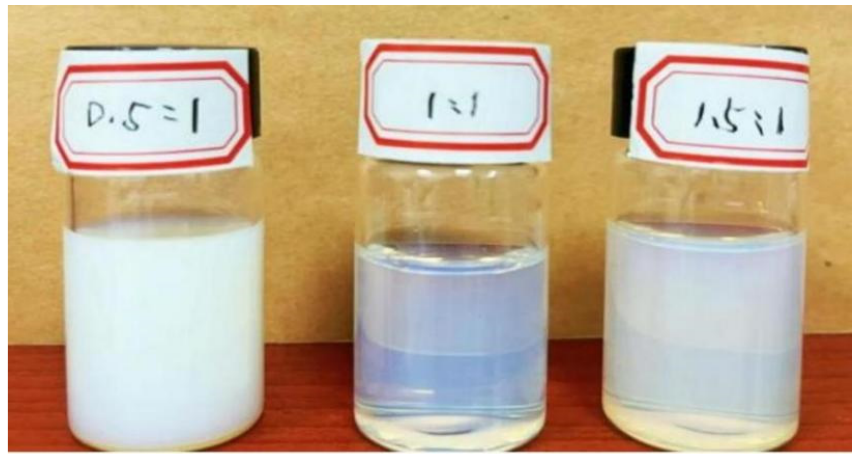
Figure 4. The effect of molar ratio of PEG1000 and E20 on the water solubility of curing agents.